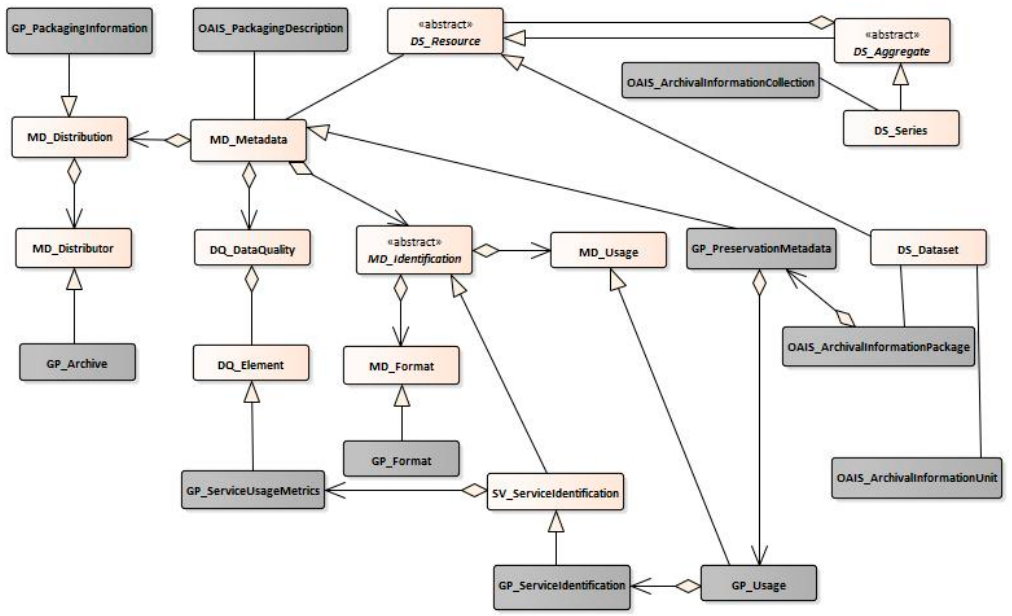
Figure 9. Specialization of 19115-1 for preservation of geographic information and metadata (Source 19165-1). Table 9. Functional requirements for preservation of geospatial data and metadata.